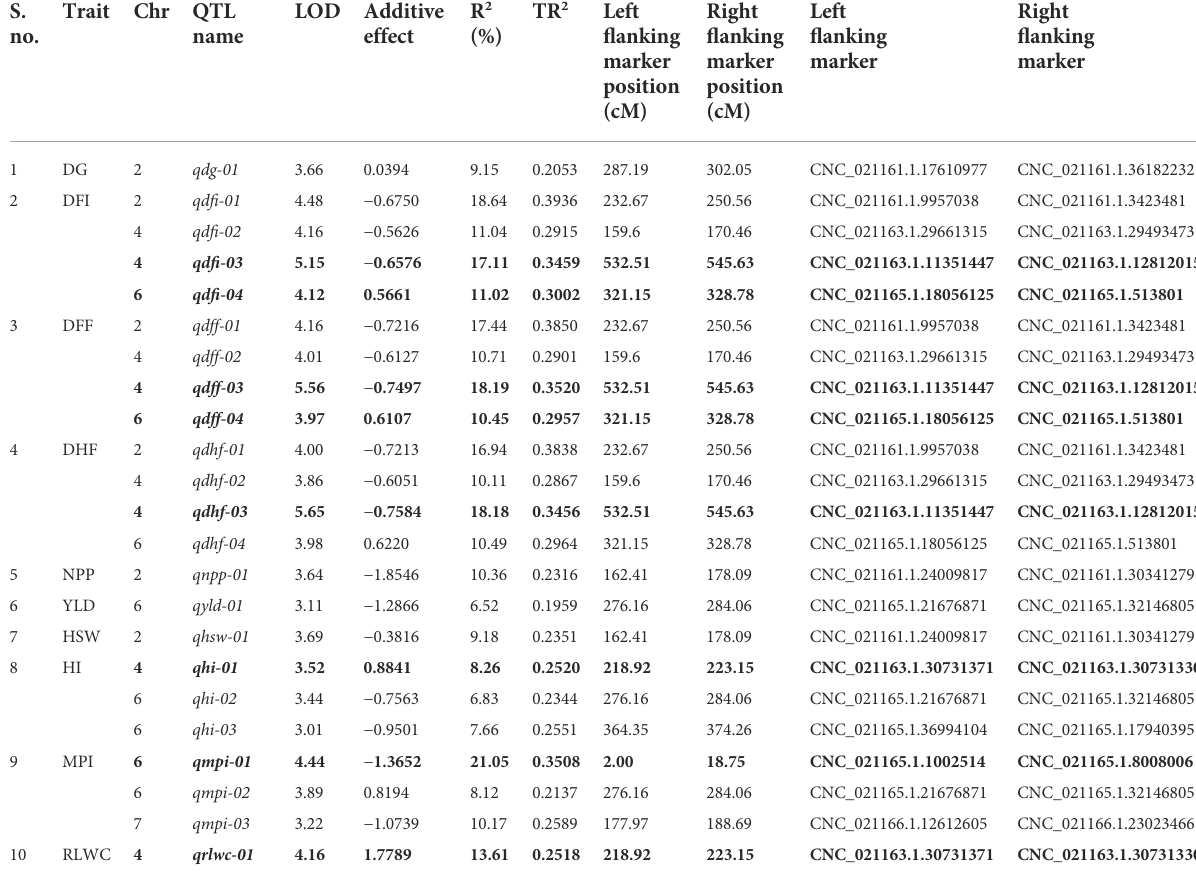
TABLE 6 Summary of QTLs associated with various morphological and physiological traits evaluated Faridkot. S. Trait Chr QTL no.